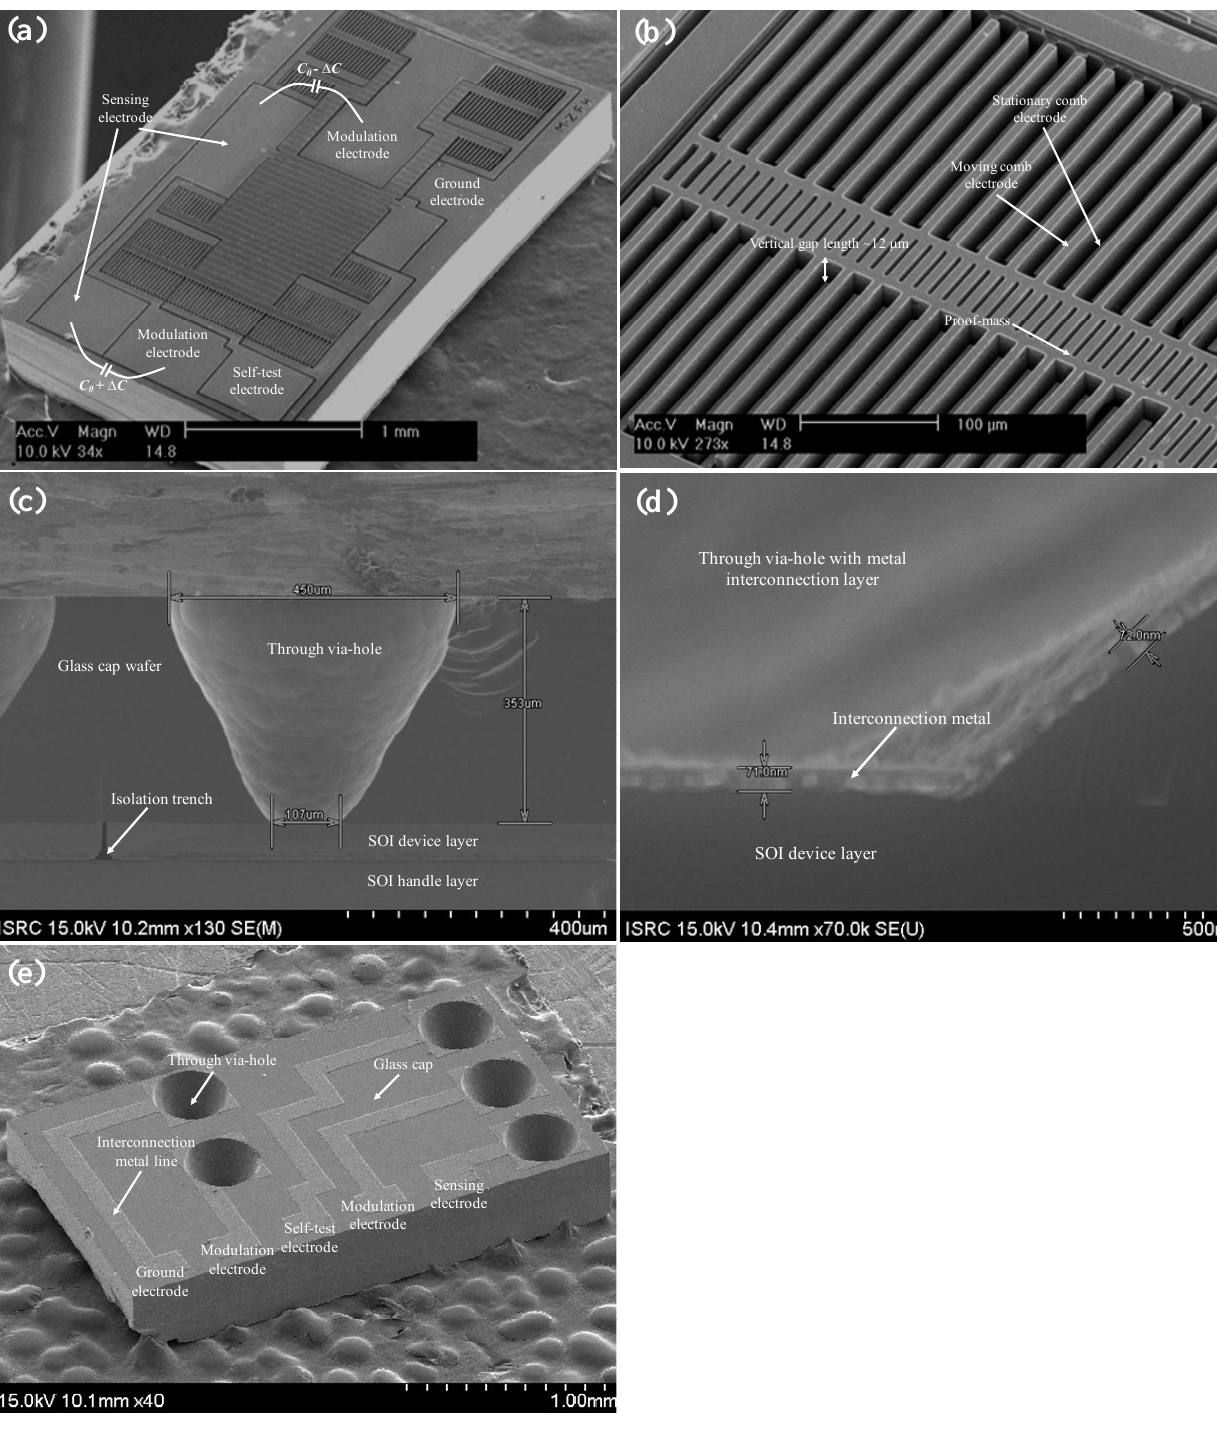
Figure 13. (a) Overall view of the fabricated silicon structure. (b) Magnified view of the fabricated vertical gap between interdigitated comb-fingers. (c) Cross-sectional view of the fabricated sensing element. (d) Magnified view of the metal interconnection layer and through via-hole. (e) Hermetic packaged MEMS sensing element. Fabricated MEMS out-of-plane